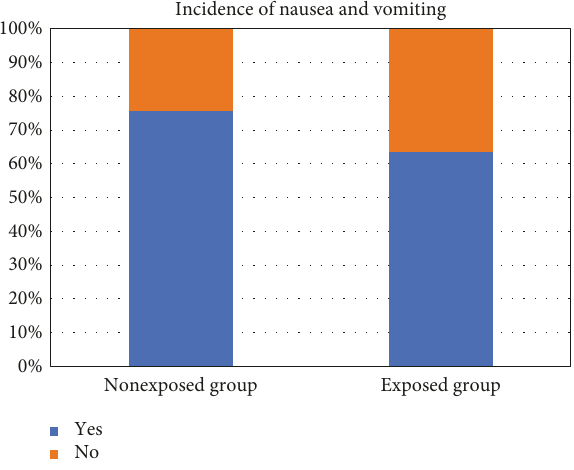
Figure 2: Incidence of nausea and vomiting between two